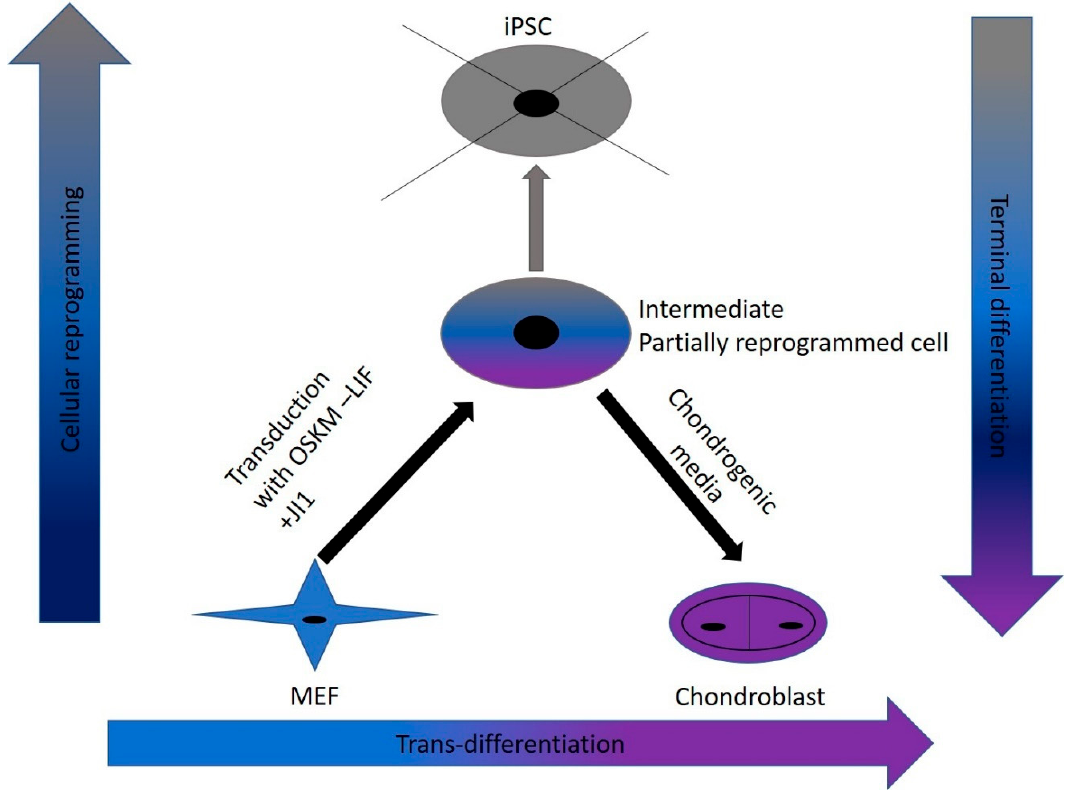
Figure 7. Schematic of the methodology used in this study. Retroviral transduction partially reprogramed MEFs in the absence of LIF and the addition of JI1. This approach put the cells into a plastic state where the chromatin is open enough for the chemicals and small molecules in the chondrogenic media to reprogram cells to chondroblasts without reaching the iPSCs state directly. Cellular reprogramming using the OSKM factors is a well-known and established method [16].